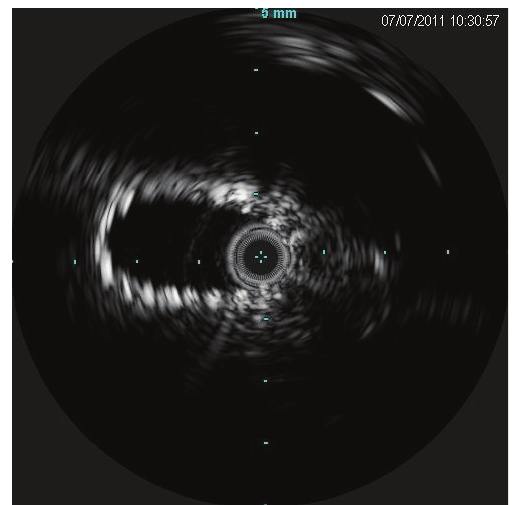
Figure 4: Poststent placement intravascular ultrasound (IVUS) in the left iliac improvement in lumen